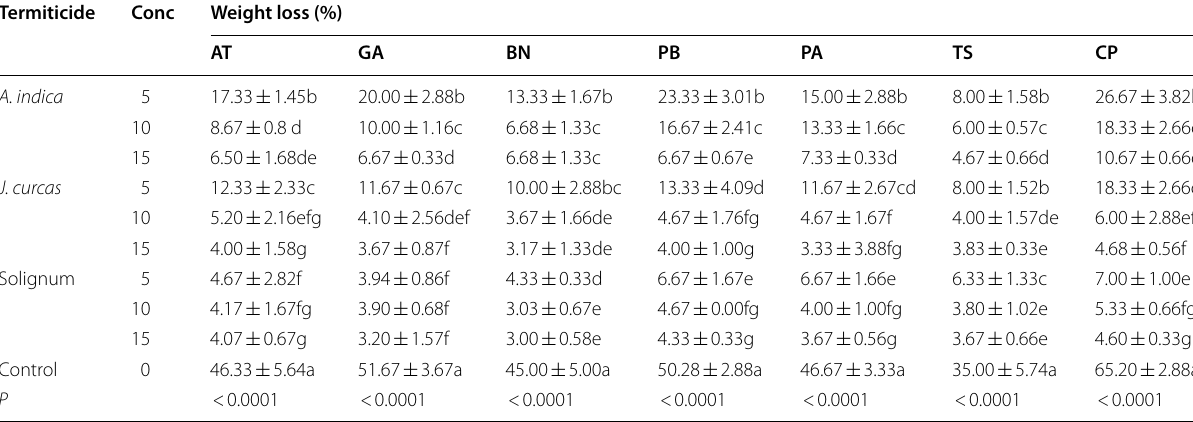
AT, Antiaria toxicera ; GA, Gmelina arborea ; BN, Baphia nitida ; PB, Parkia biglobosa ; PA, Pycnanhus angolensis ; TS, Terminalia superba ; CP, Ceiba pentandra ; Data (%) were transformed (arcsine) before the analysis of variance; Means ( Standard error) are values of four replicates ; Means with the same lower case alphabet in a column are ± not significantly different from each other (DNMRT: P > 0.05); b concentration (mL/ 100 m 3 of wood surface); P , Probability value